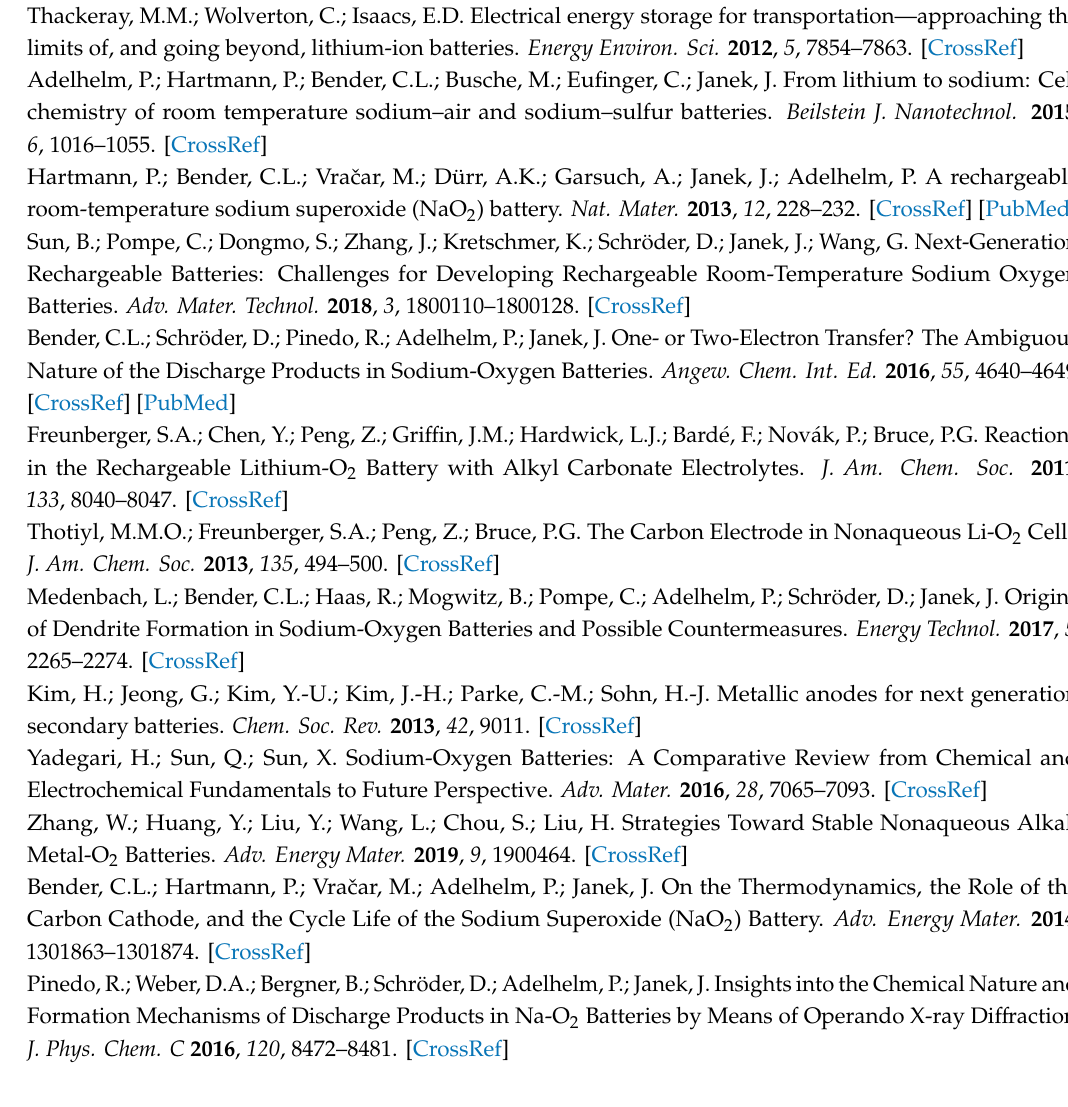
Figure S1: Obtainable discharge capacity for various t rest / t pulse times, Figure S2: Histogram for NaO 2 cuboid edge length, Figure S3: PCD and charging profiles, Figure S4: Long-term NaO 2 degradation